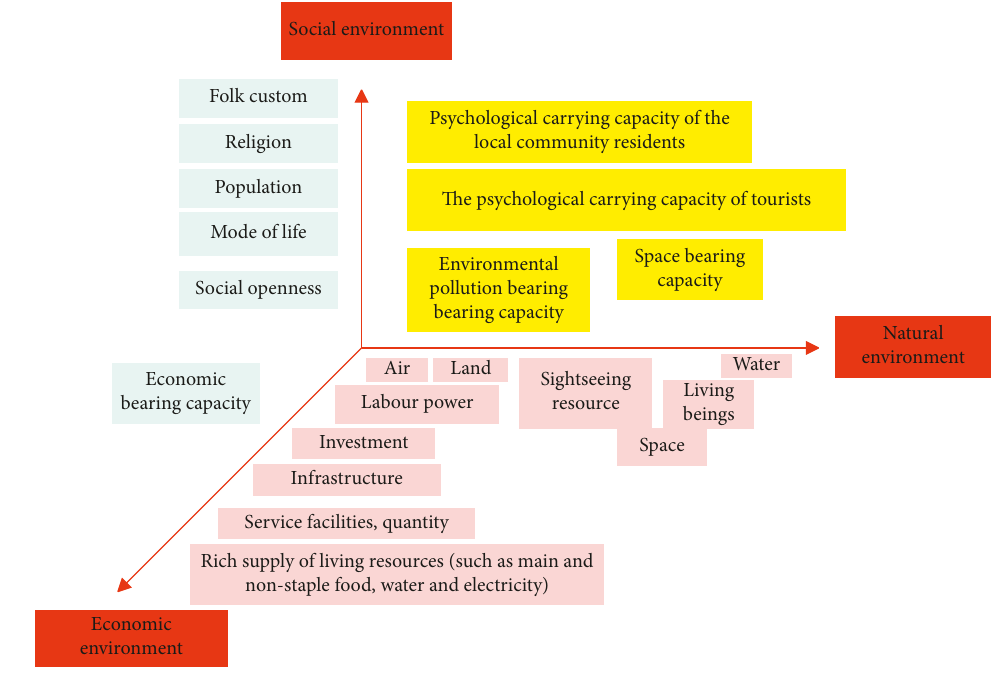
Figure 7: Composition system of tourism environment carrying capacity.